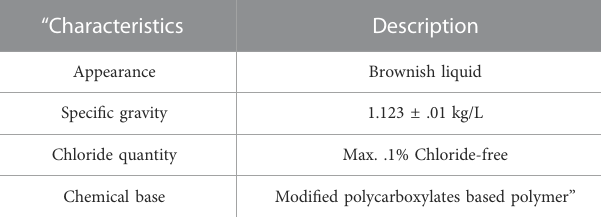
TABLE 4 Speci fi cation of superplasticizer Qaidi et al. (2022a). “